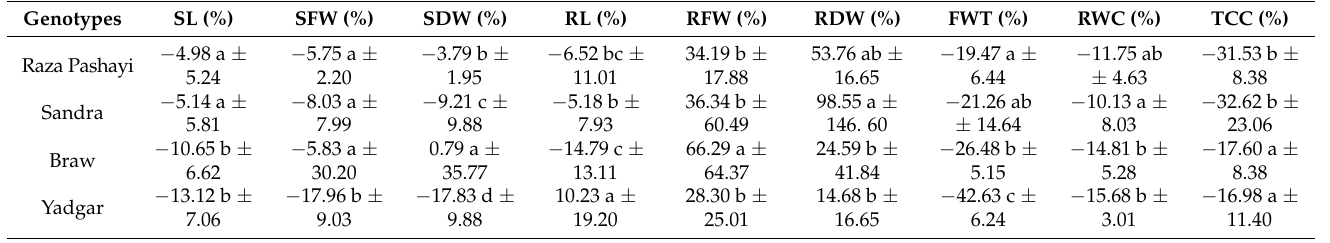
Table 3. Impact of tomato genotypes treated with oak leaf powder, oak leaf extract, and biofertilizer at different stress stages on the morpho-physiological traits. Increasing and declining percentages are represented by positive and negative values,